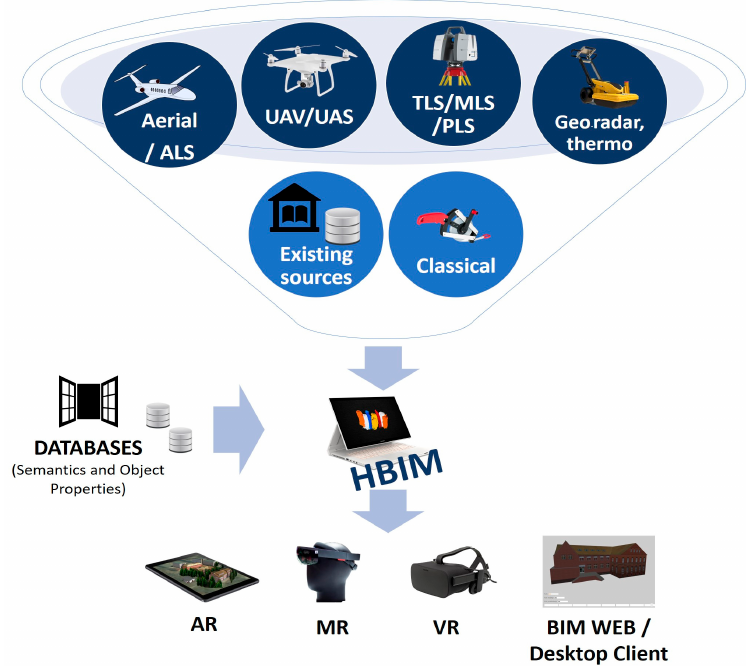
Figure 1. A typical methodology for implementation of an HBIM.